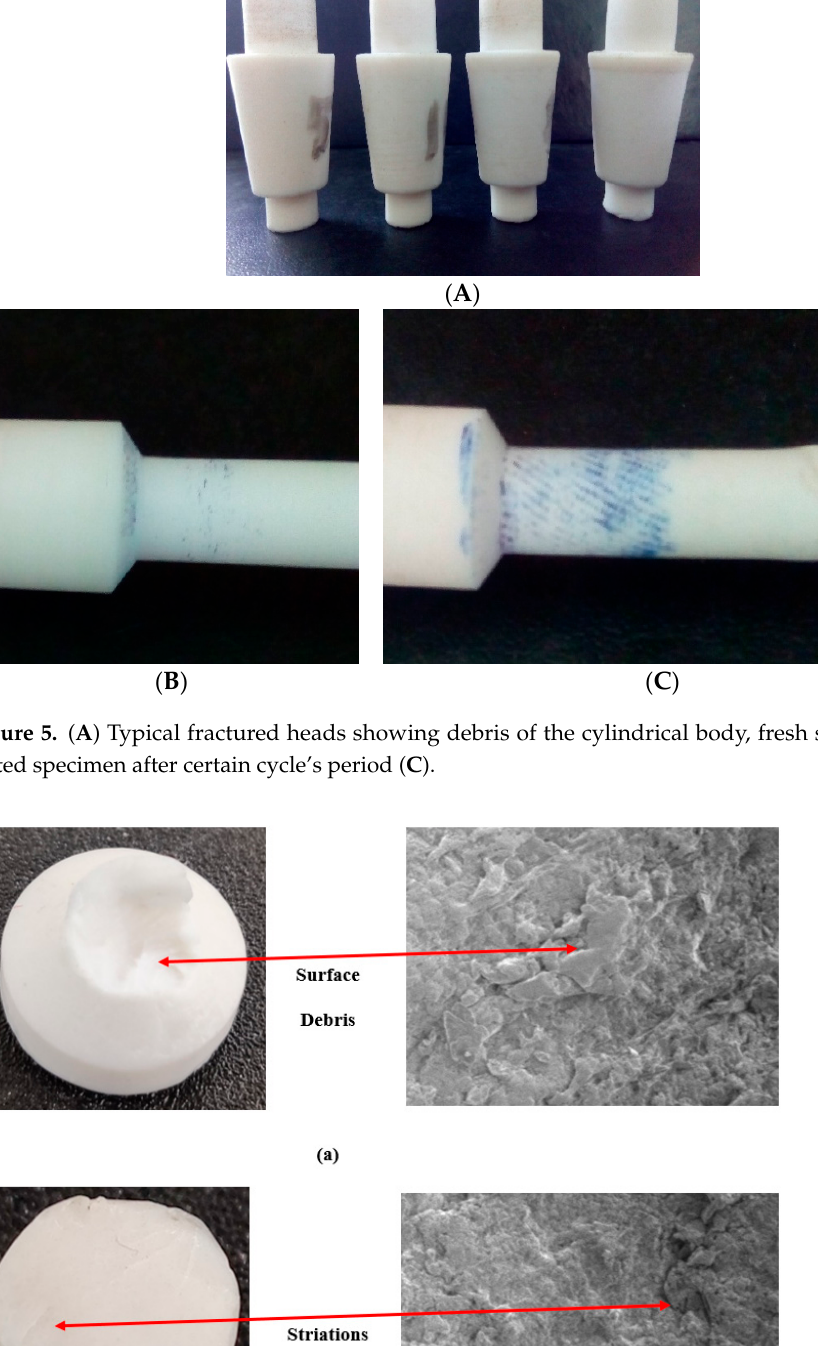
Figure 7. Schematic diagram of fractured PTFE surface.